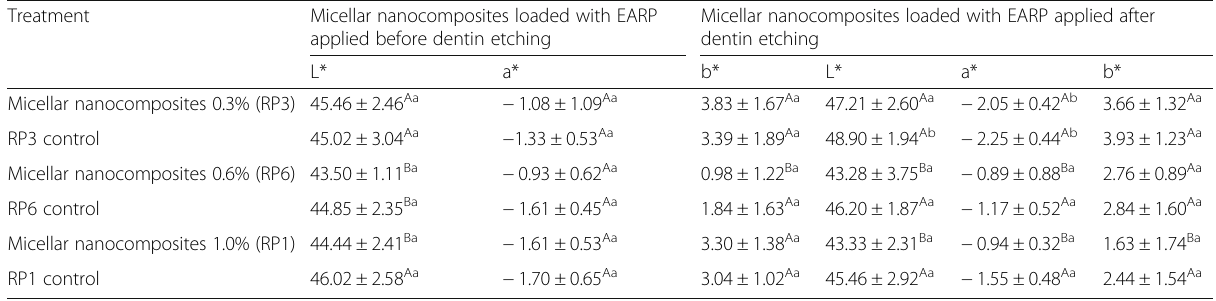
Table 4 Means ± standard deviation of the color characteristics in the L*a*b* color space (CIELAB) for each experimental group and the control groups